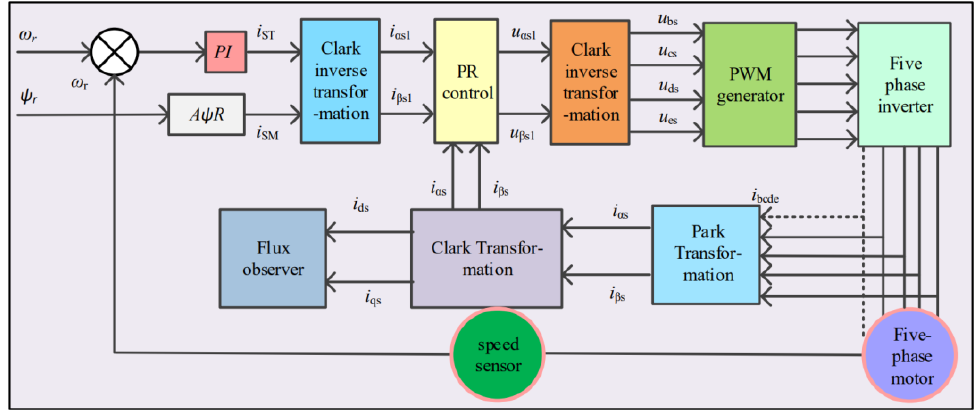
Figure 3. Five − phase induction motor fault − tolerant control block diagram. Figure 3. Five-phase induction motor fault-tolerant control block Table 1. Parameters of five − phase induction motor.